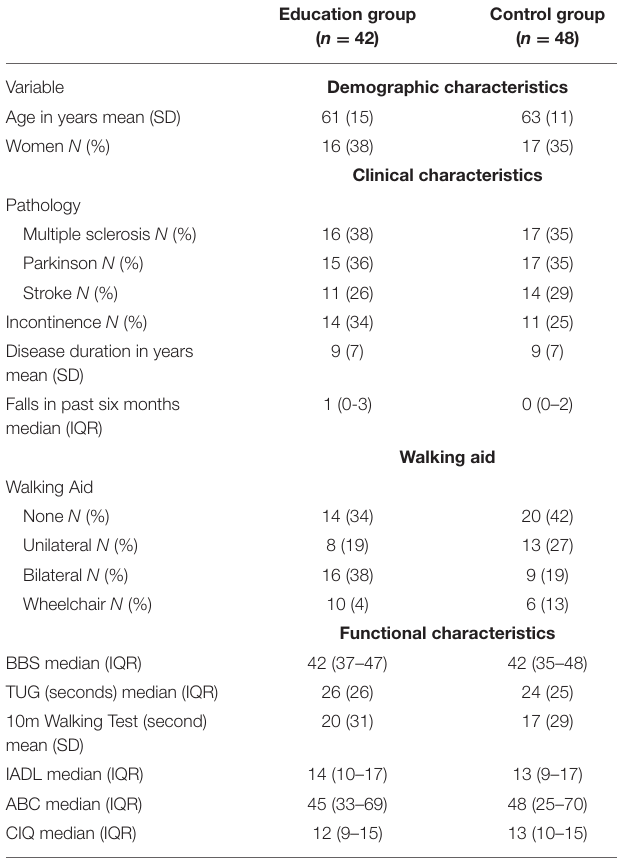
TABLE 1 | Clinical and demographic characteristics of the